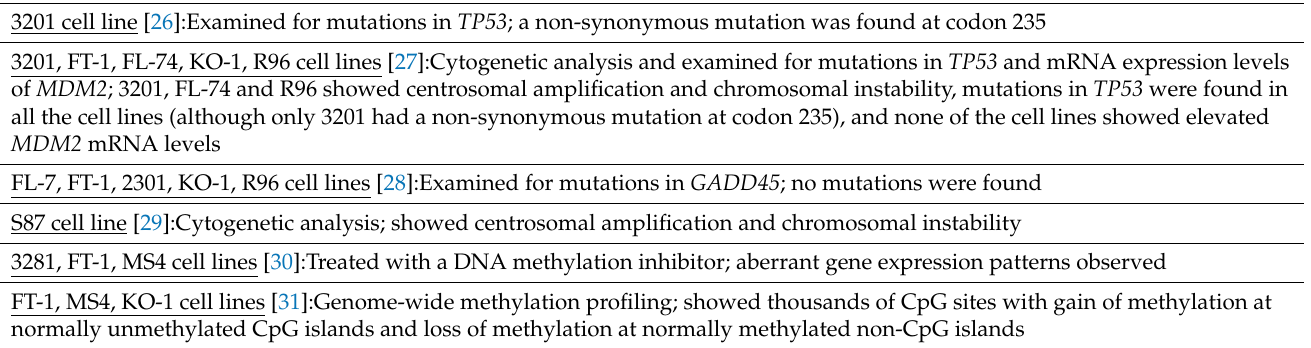
Table 2. Examples of feline lymphoma cell lines and how they have been used to understand the genetics of feline